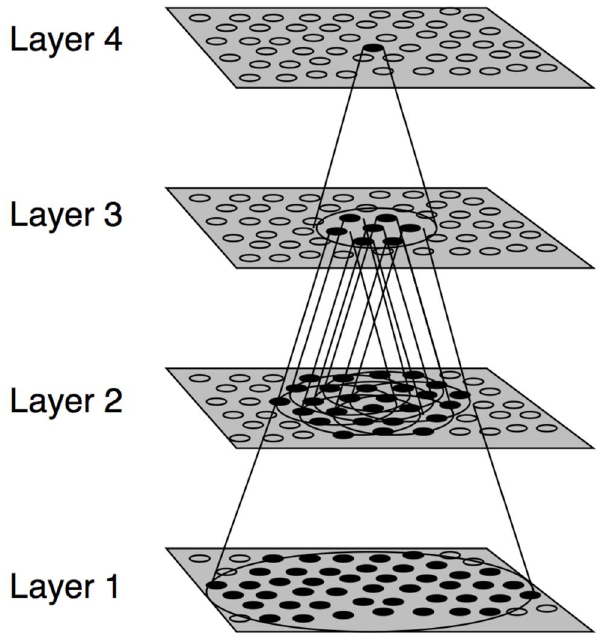
Figure 2. The VisNet model. Stylized image of the VisNet four- layered network. The architecture of the network shows a hierarchical organization which can be found in the dorsal visual system. Convergence through the network is designed to provide fourth-layer neurons with information from across the entire input retina.